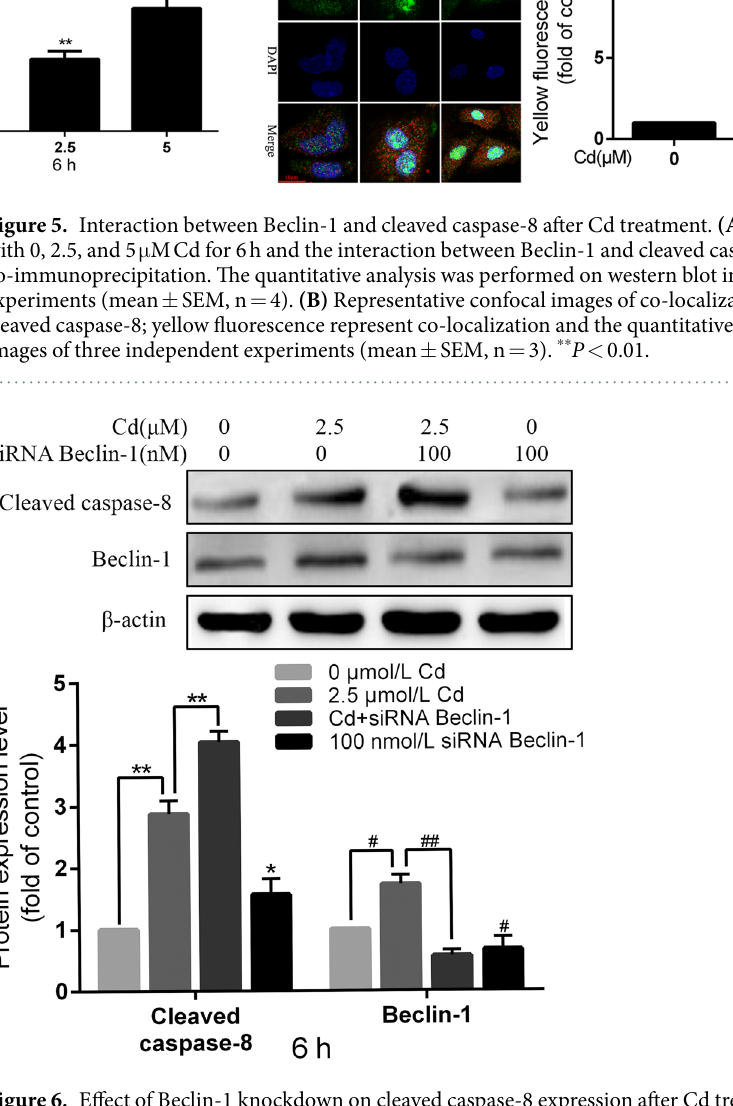
Figure 6. Effect of Beclin-1 knockdown on cleaved caspase-8 expression after Cd treatment. Cleaved caspase-8 and Beclin-1 protein levels were assessed by western blot analysis after 2.5 μ M Cd and/or 100 nM siRNA Beclin-1 treatment 6 h. The quantitative analysis performed on western blot images from four independent experiments (mean ± SEM, n = 4). * P < 0.05, ** P < 0.01, # P < 0.05 and ## P <